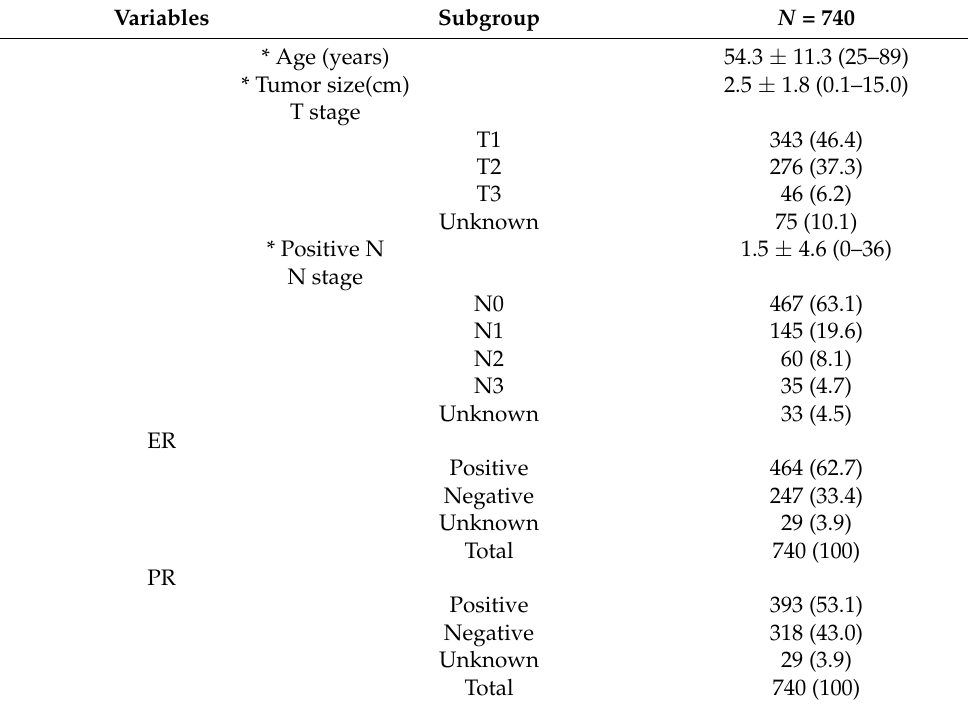
Table 1. Clinicopathologic characteristics of the patients.